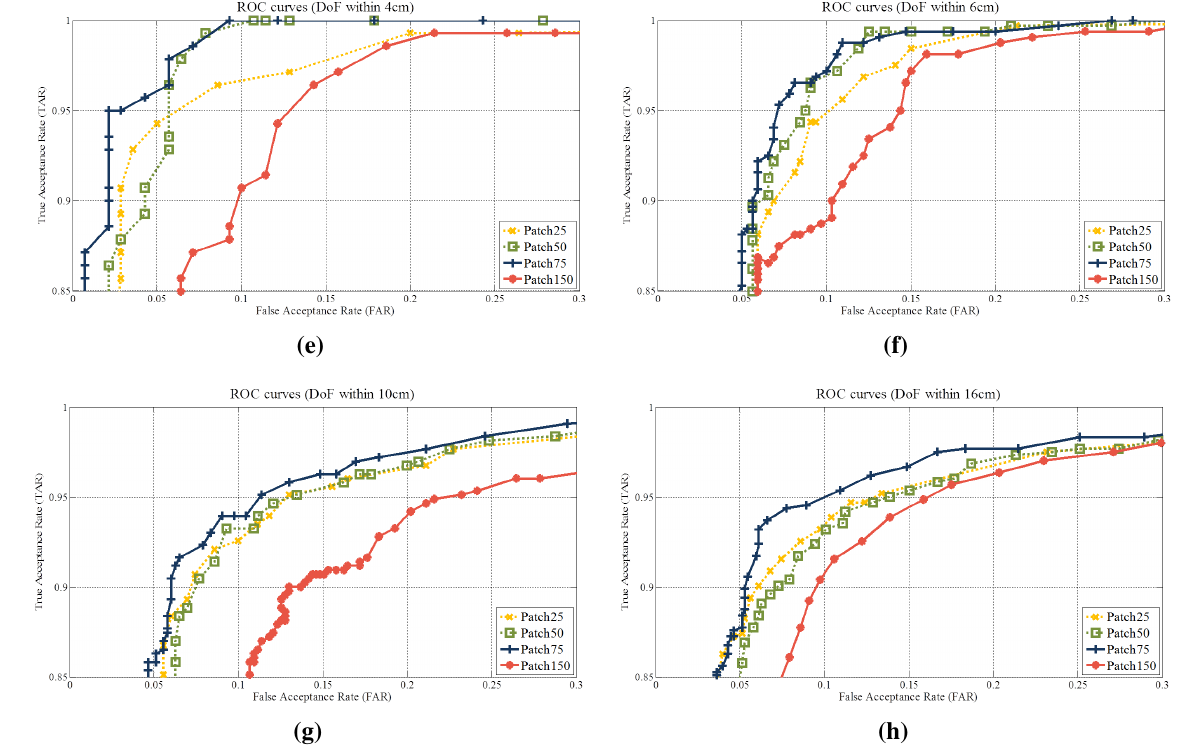
Figure A3. ROC curves of the GLOH features (overlap: PCA 90%, DoF ( a ) within 4 cm, ( b ) within 6 cm, ( c ) within 10 cm and ( d ) within 16 cm; and NO overlap: PCA 90%, DoF ( e ) within 4 cm, ( f ) within 6 cm, ( g ) within 10 cm and ( h ) within 16 cm). Conflicts of Interest The authors declare no conflict of